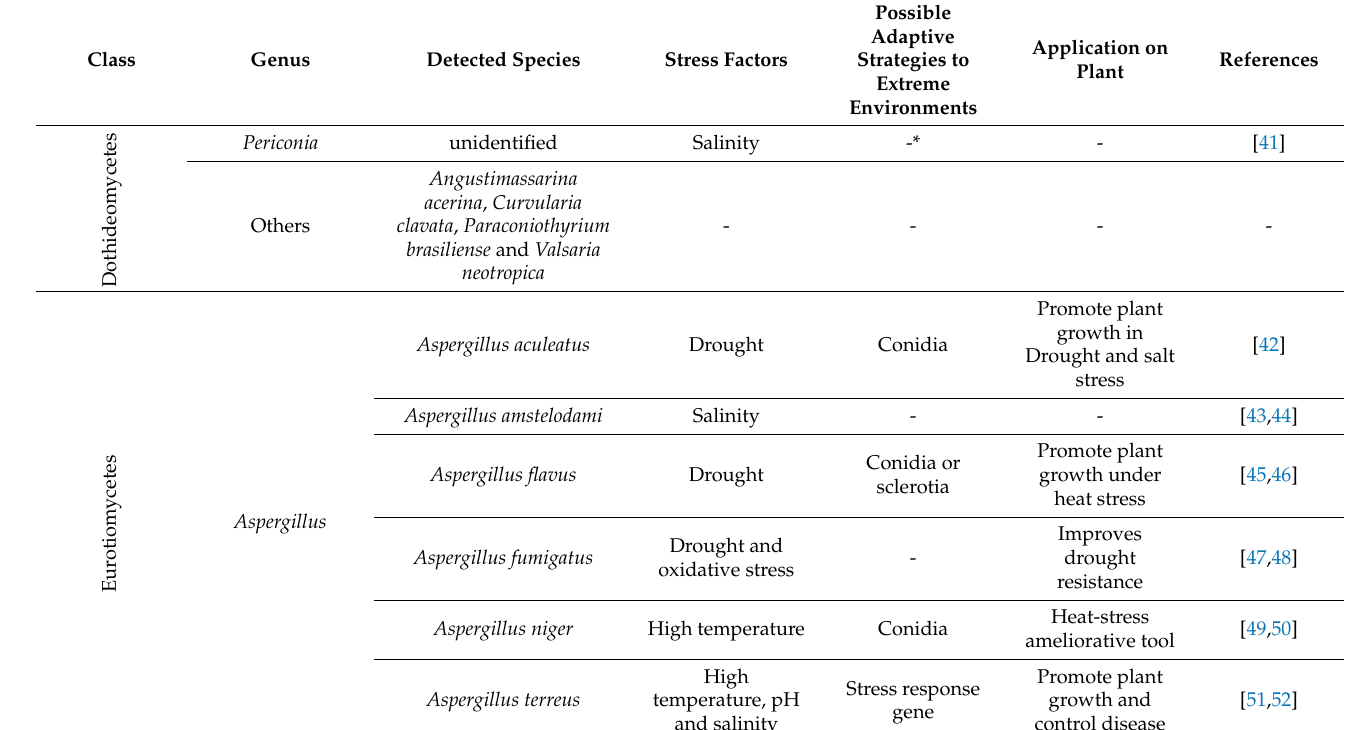
Table 1. Living fungi detected in the opencast limestone